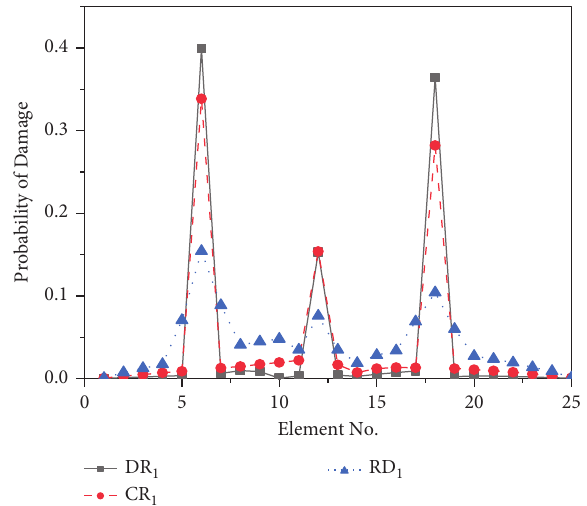
1 (a), CR 1 (b), and RD 1 (c).